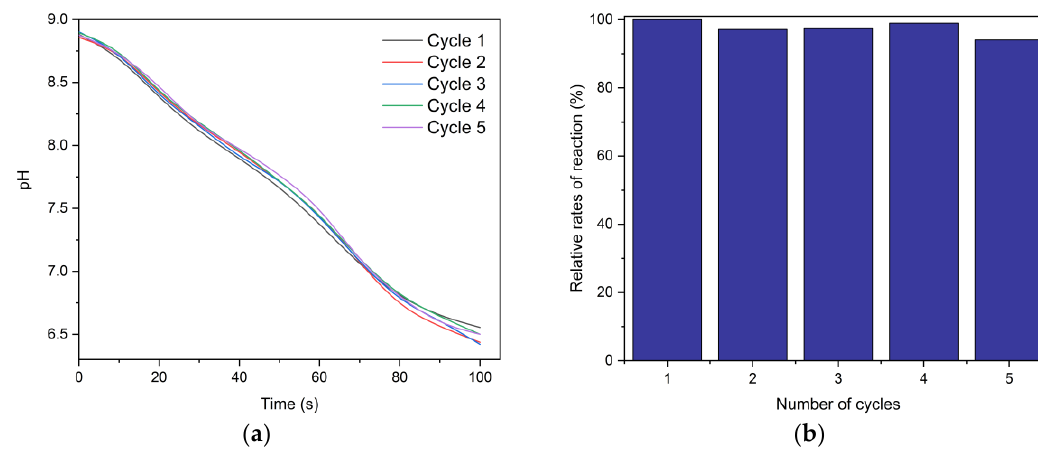
Figure 5. Reusability study of Zn(II)-Au@IHQ-NP for the catalyzed hydration of CO 2 . ( a ) Delta-pH graphs of five cycles of CO 2 hydration. ( b ) Relative rates of reaction determined over 5 cycles of CO 2 hydration.